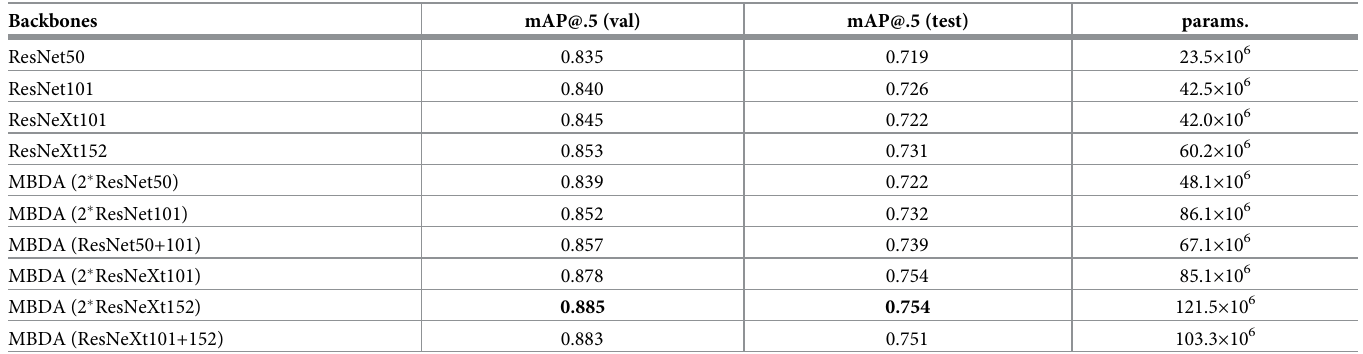
Table 2. Different MBDA